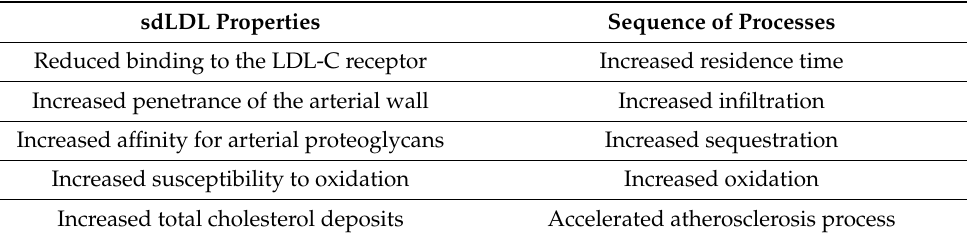
Table 2. Overall characteristics of small, dense low-density lipoproteins (sdLDL) summarized as a series of sequential